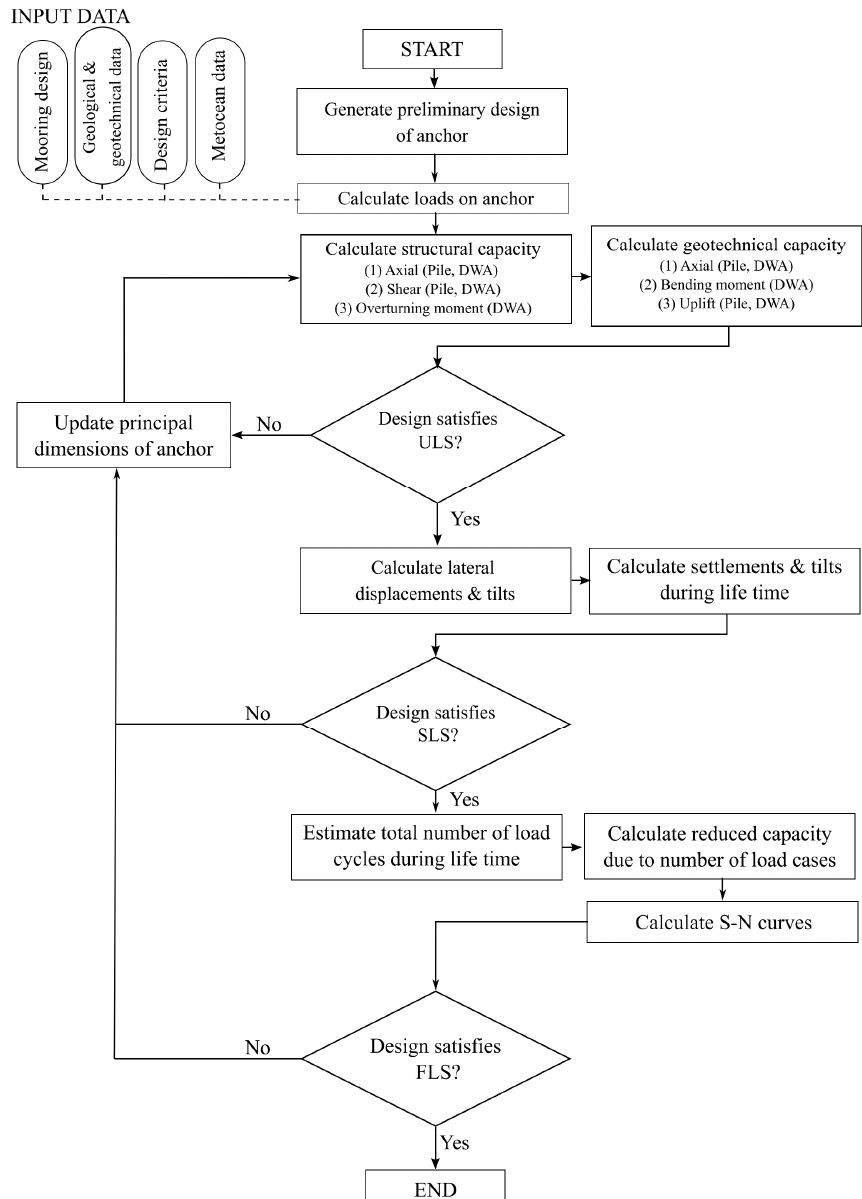
Figure 2. Flow chart of the proposed design procedure.